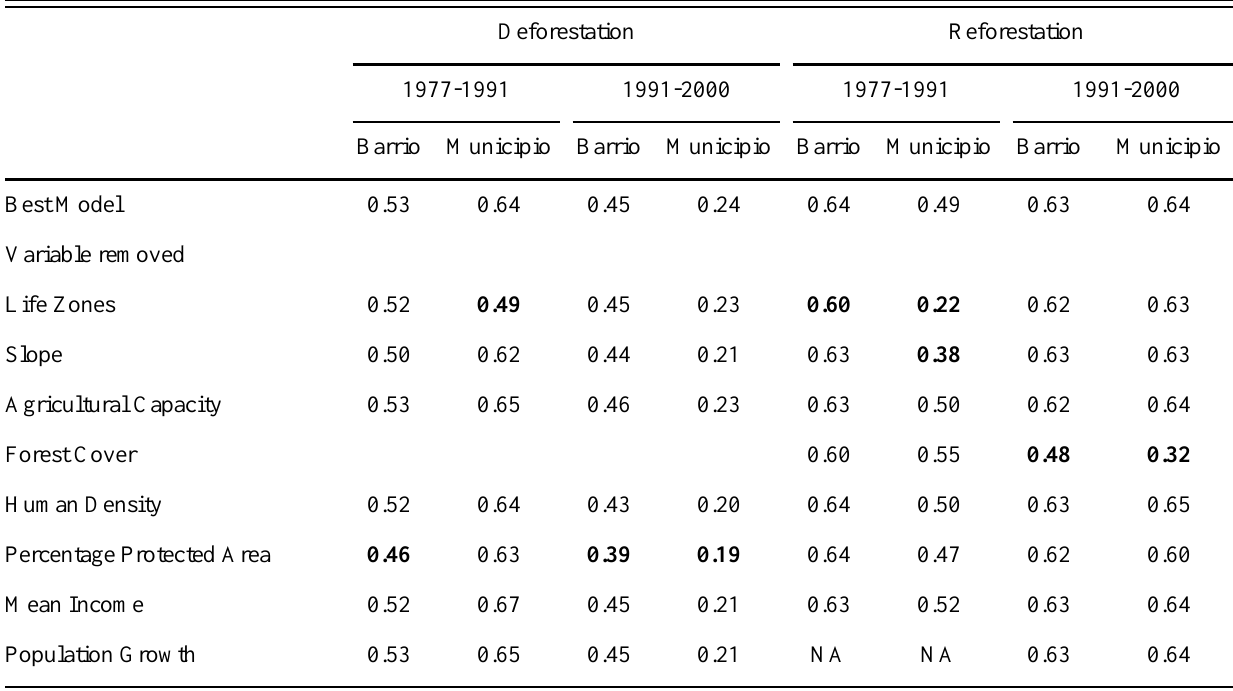
Table 2. Explained variance at barrio (submunicipality) and municipio levels for best models of deforestation and reforestation during two time periods (1977-1991 and 1991-2000) and explained variance in models where individual explanatory variables are removed from best model. The decrease in R² relative to the best model indicates the importance of that variable in predicting observed transitions. The best model does not necessarily have the best R² at a particular scale because model selection is based on the overall agreement between data and the model; in other words, the ability to simultaneously explain variance at all levels of a multilevel